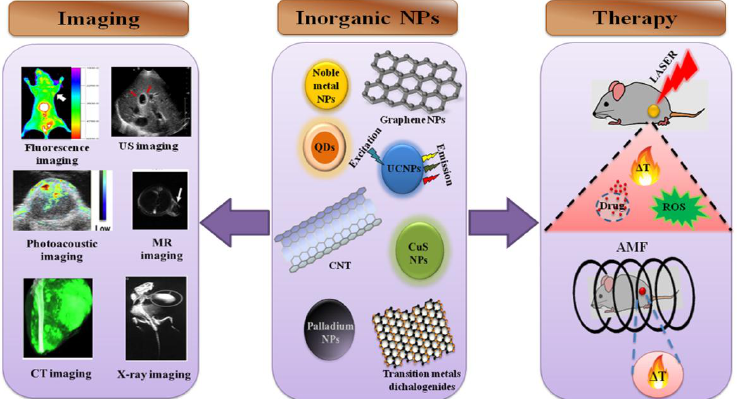
Figure 1. Scheme illustrating the potential of inorganic nanoparticles in heat-induced therapies and imaging. US: ultrasound; MR: magnetic resonance; CT: computed tomography; QD: quantum dot; UCNP: upconversion nanoparticles; CuS: copper sulfide; CNT: carbon nanotube; AMF: alternate magnetic field; ROS: reactive oxygen species.